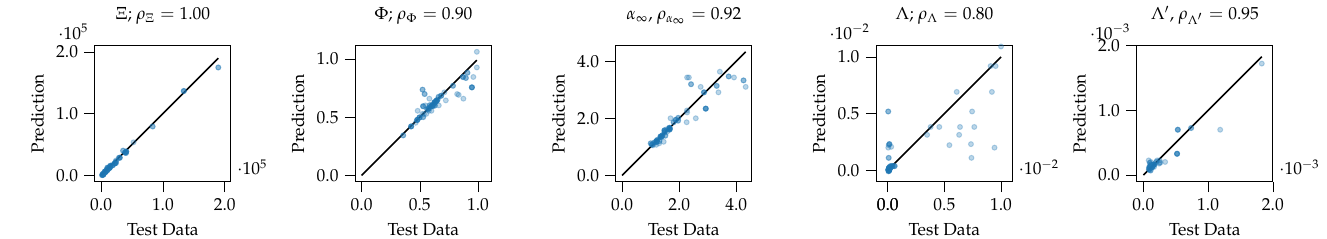
Figure 4. Correlations of correct model parameters (input to the ANN) and the prediction of the ANN. The data shown are the test dataset only (unseen data during training). The correlation is measured using Pearson’s correlation coefficient ρ . Greek letters denote the JCA model parameters, i.e., Ξ : flow resistivity, Φ : porosity, α ∞ : tortuosity, Λ , Λ (cid:48) : viscous and thermal characteristic length,